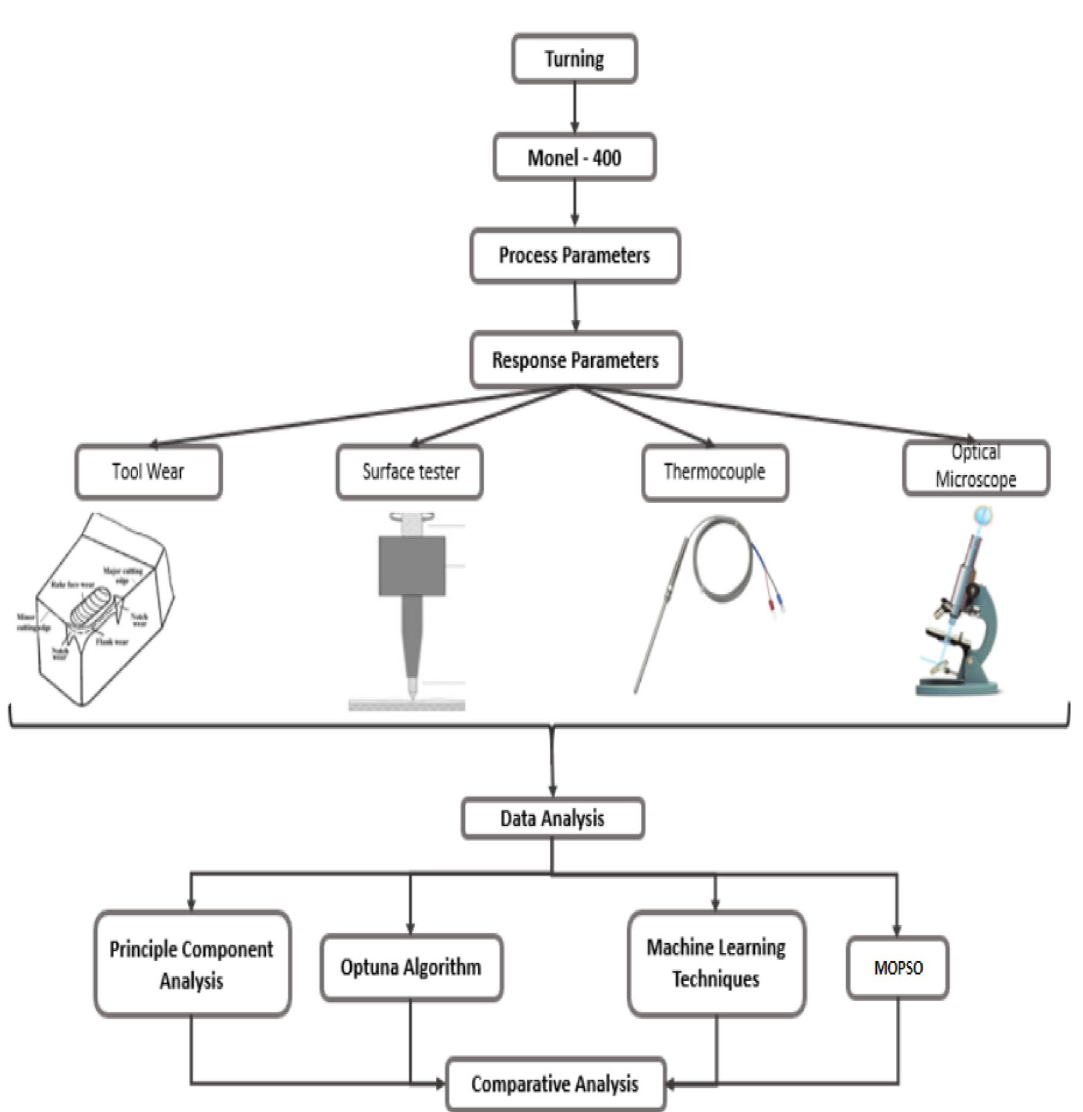
Fig. 1 Schematic representation of experimental set